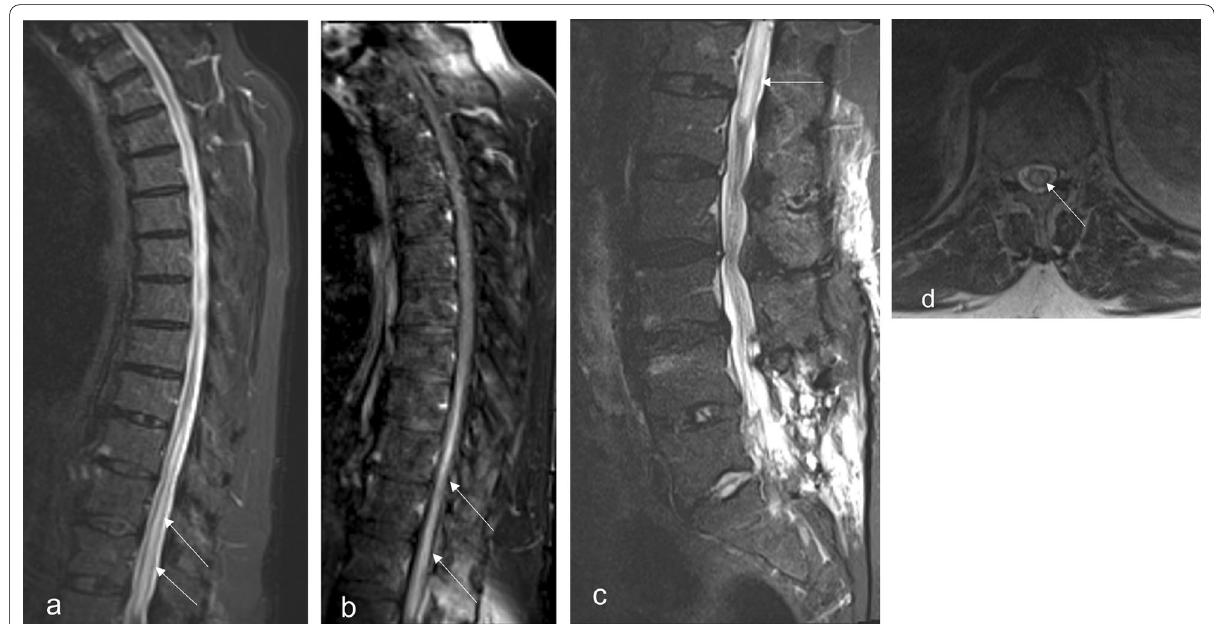
Fig. 1 Sagital Stir ( a ) and post contrast T1W fat saturated ( b ) images through the thoracic spine, sagital Stir image through the lumbar spine ( c ) and axial T2 weighted image at the T12 level ( d ), demonstrate a long segment of thoracolumbar expansile intramedullary cord signal abnormality and enhancement (arrows). Post surgical changes of prior decompressive laminectomy in the lumbar spine are